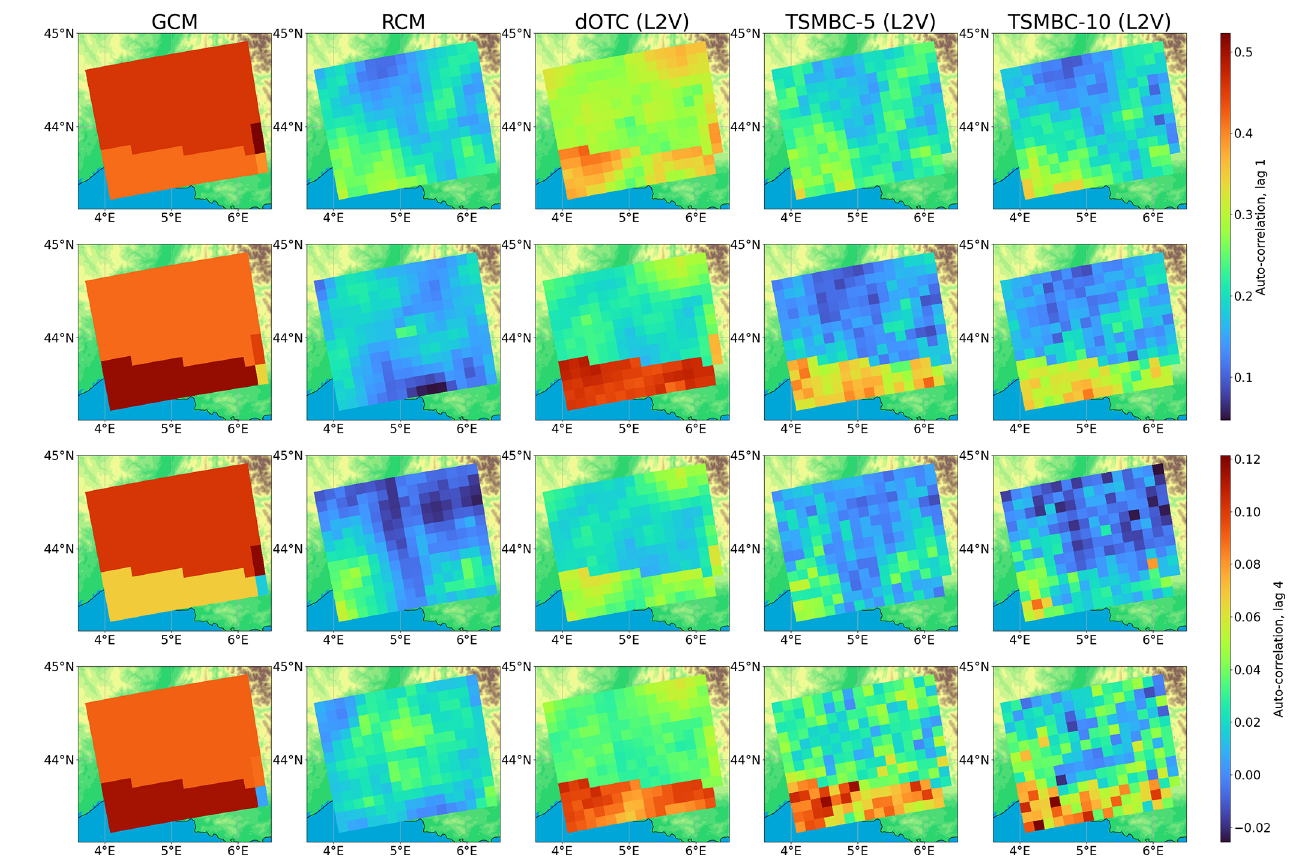
Figure 6. Map of lag-1 (two first rows) and lag-4 (two last rows) auto-correlations of precipitation in summer. The first and third rows are for the calibration period, the second and fourth rows are for the projection period. The first (and second, third, fourth and last, respectively) column gives the maps of auto-correlations of the RCM to be corrected (the GCM, the correction dOTC, the correction TSMBC-5 and the correction TSMBC-10 with method L2V, respectively). A key point of this figure is to compare the evolution between calibration and projection periods for the RCM, GCM and corrections. The evolution of the TSMBC corrections is similar to the GCM evolution, which is different from the RCM evolution, leading to a failure of the correction in projection